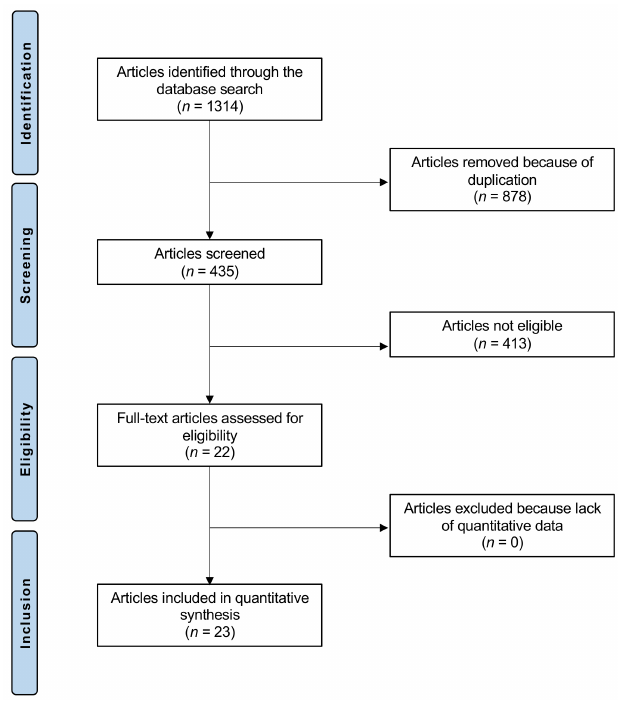
Figure 1. Flow chart of the literature